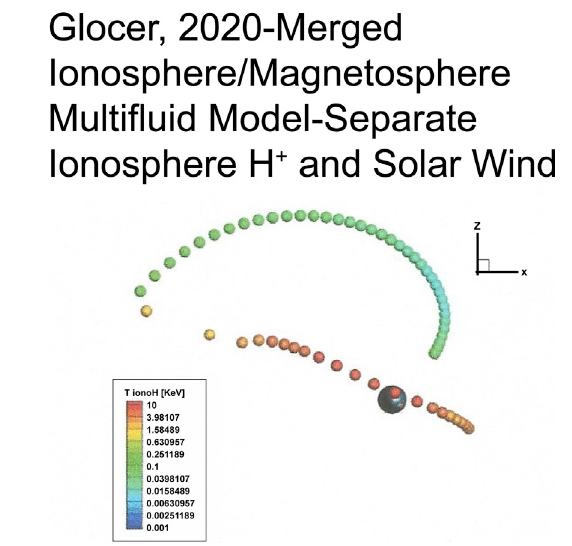
FIGURE 10 | An ion trajectory beginning above the dayside ionosphere and its movement through the polar cap and lobe to become energized upon entry into the plasma sheet and ring current (Glocer et al., 2020).